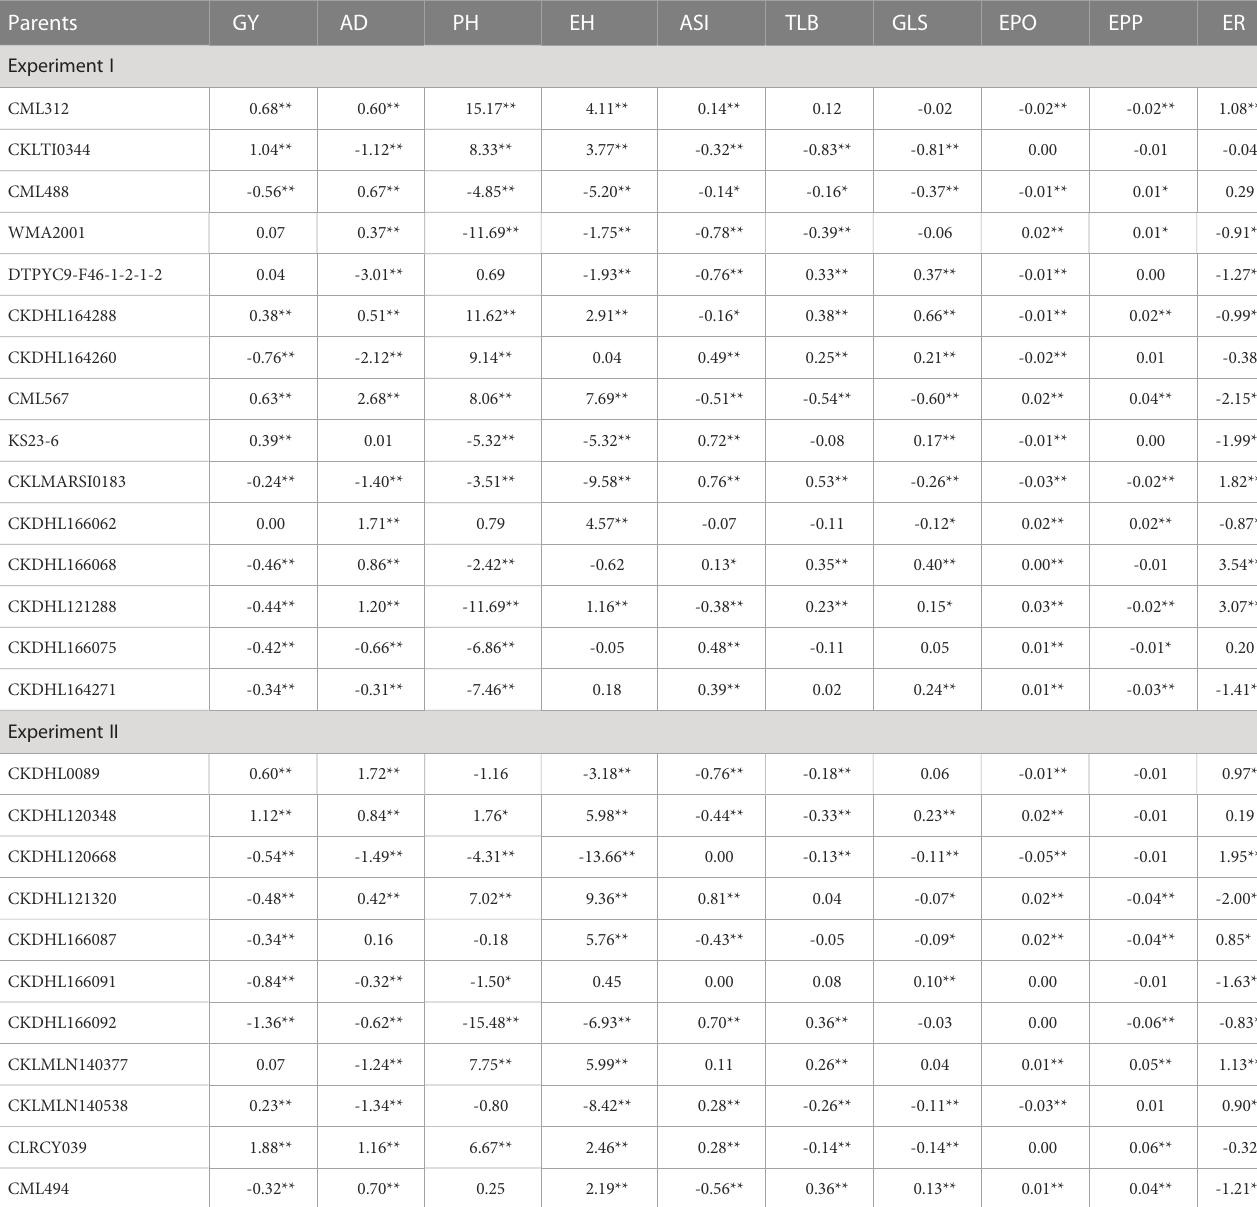
TABLE 7 General combining ability effects of the white maize inbred lines for grain yield and other traits evaluated under optimum